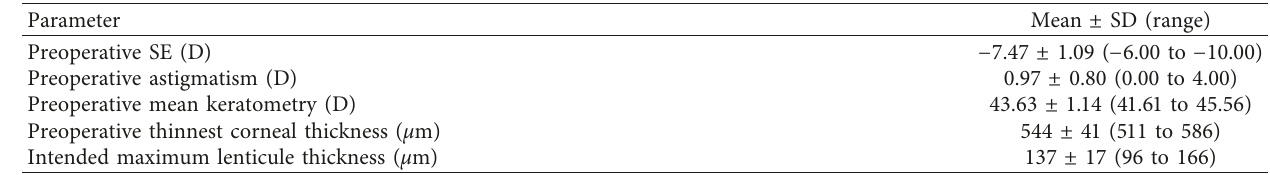
Table 1: Preoperative